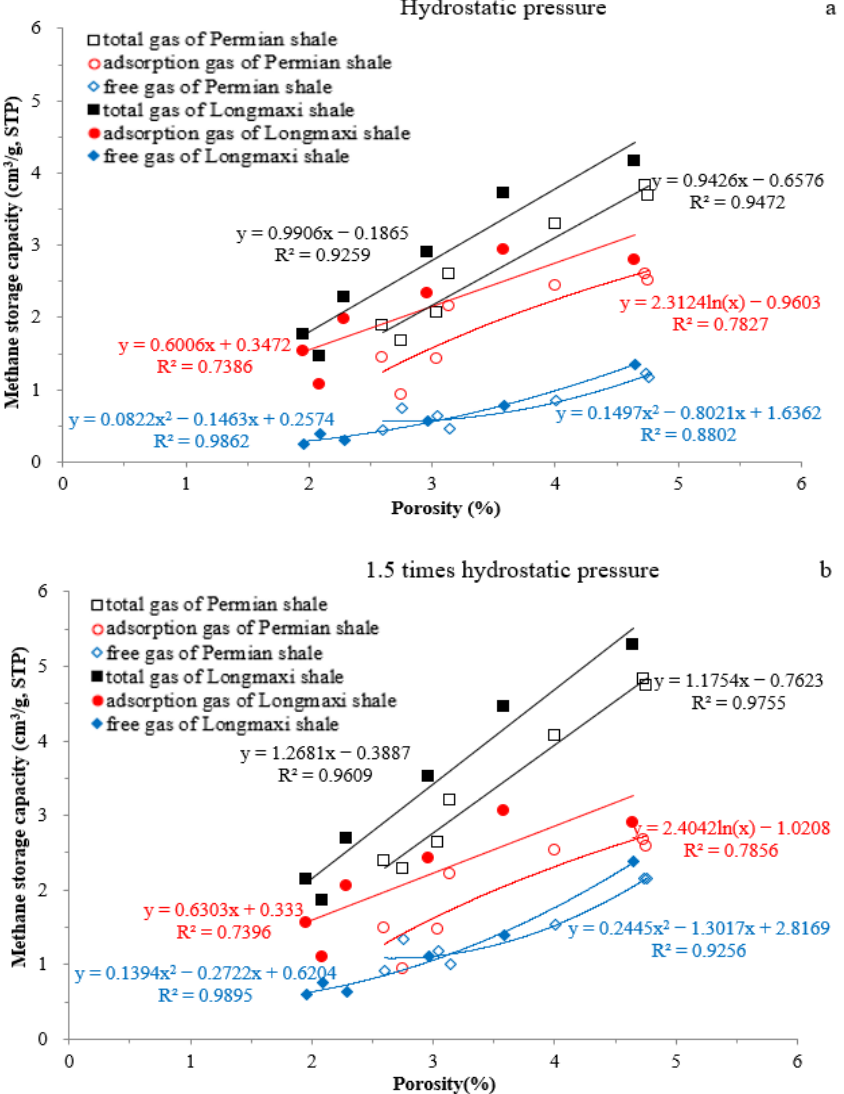
Figure 14. Plots showing the relationships of the porosity and the MSC of the Permian and Lower Silurian shales [8] under hydrostatic pressure ( a ) and 1.5 times hydrostatic pressure ( b ). The set reservoir temperature is 60 °C, corresponding buried depth of approximately 2000 m. The water saturation is 30% for the reservoir with hydrostatic pressure, and 20% for the reservoir with 1.5 times hydrostatic pressure.